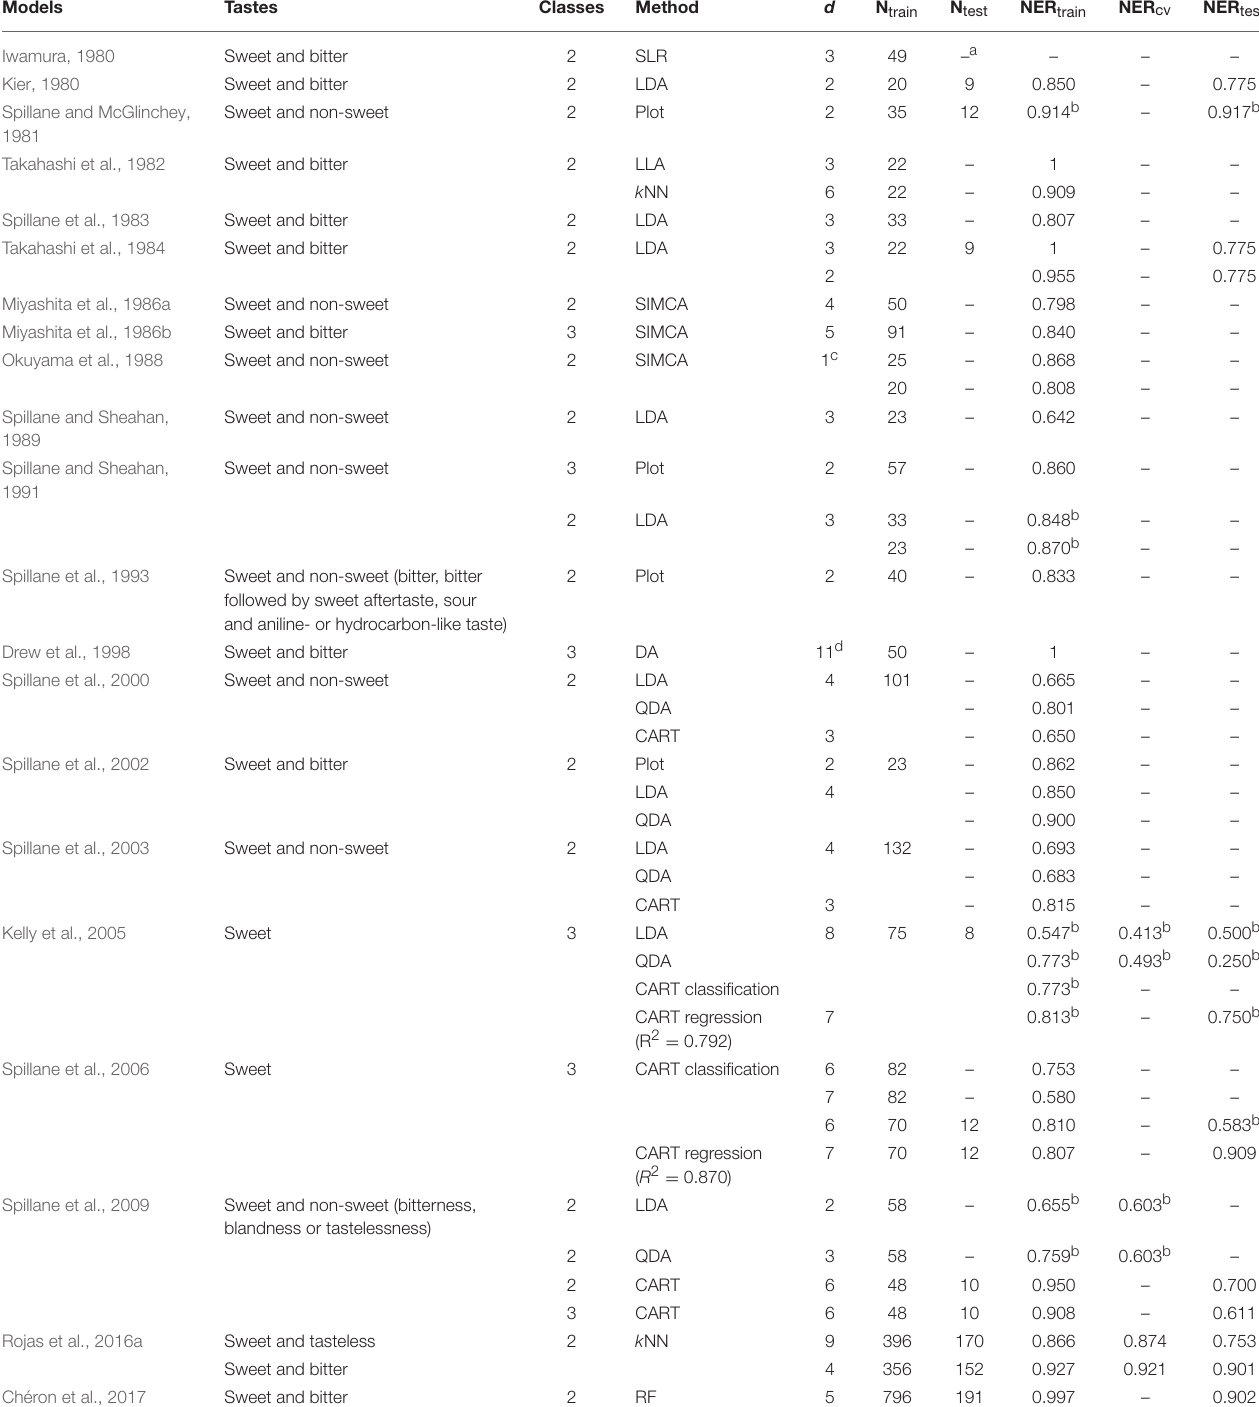
TABLE 1 | Summary of the performances of the QSTR classification models reported in the literature for predicting sweet taste of molecules.